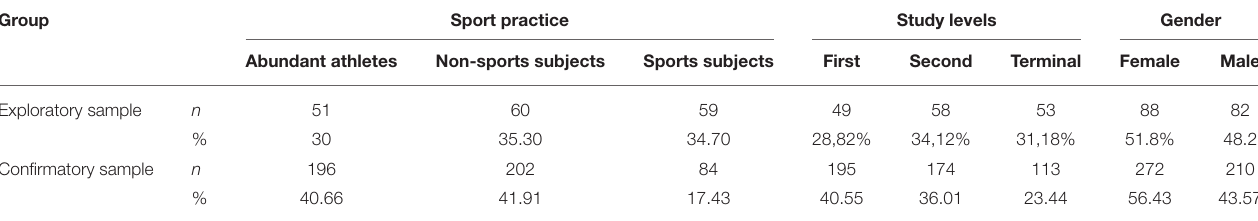
TABLE 1 | Distribution of participants by sport practice, study level, and gender. Group Sport practice Study levels Gender Abundant athletes Non-sports subjects Sports subjects First Second Terminal Female Male Exploratory sample